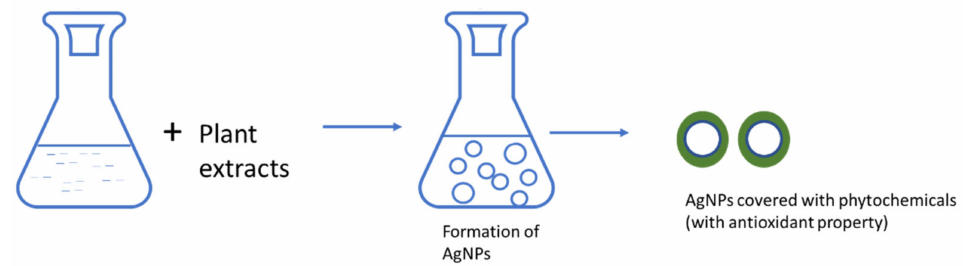
Figure 6. Silver nanoparticles with antioxidant